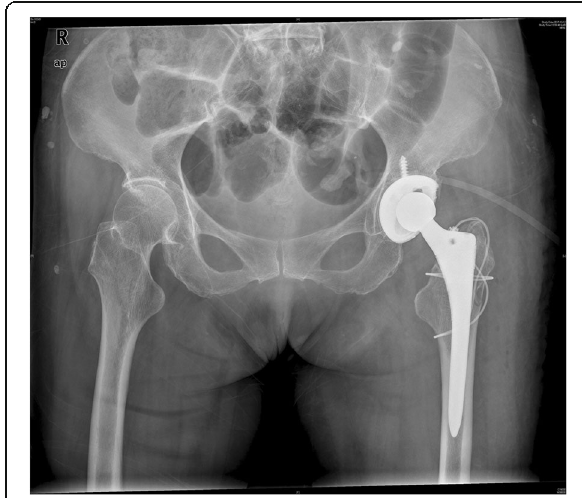
Fig. 5 Anteroposterior radiograph 2 years after ORIF showed reduction and fixation of the fracture, the fracture healed well, and the stem was